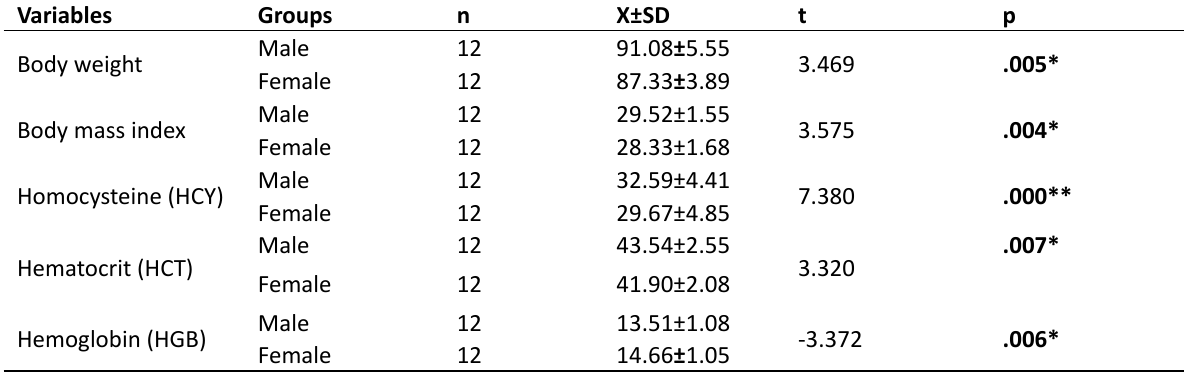
Table 4. Comparison of the pretest posttest values of the male participants